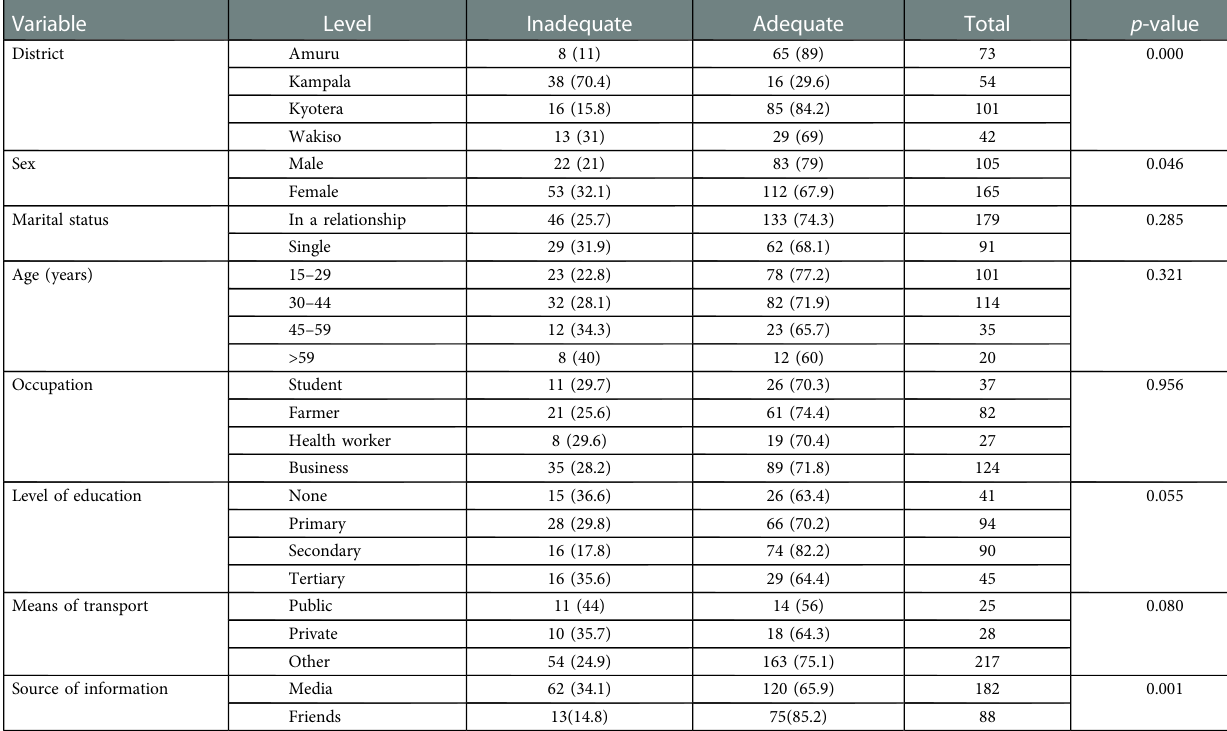
TABLE 2 Distribution of knowledge of COVID-19 prevention measures according to demographic characteristics. Variable